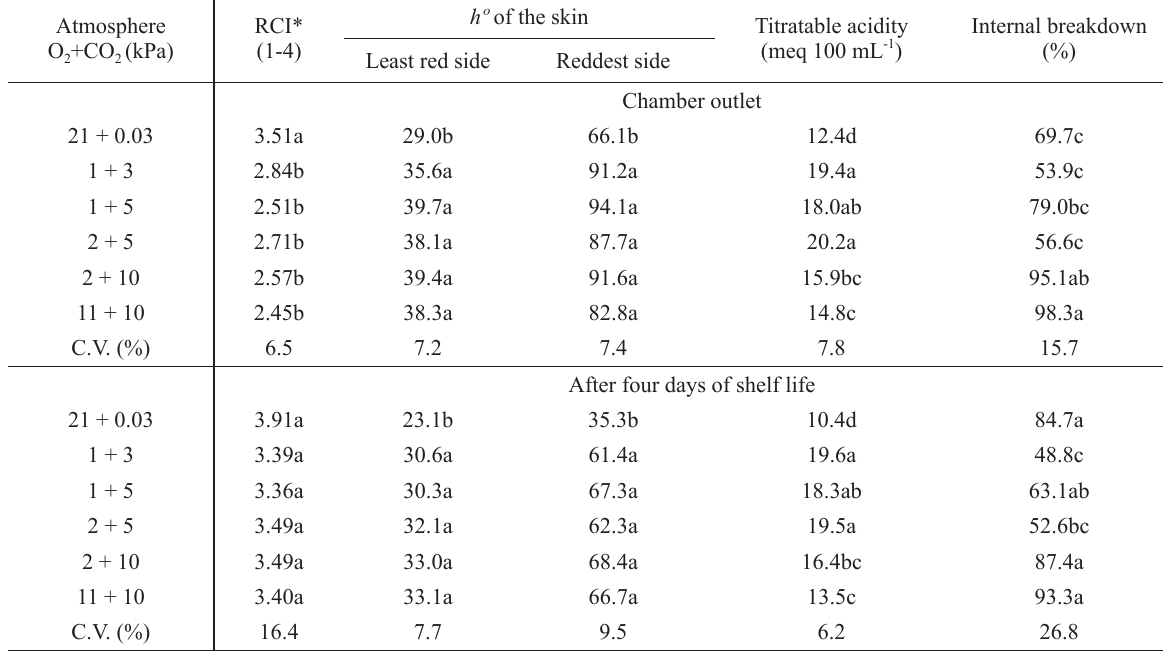
Red color index (RCI) and hue angle ( h o ) of the skin, titratable acidity and internal breakdown in ‘Laetitia’ plums stored at 0.5°C under different atmospheres for 60 days